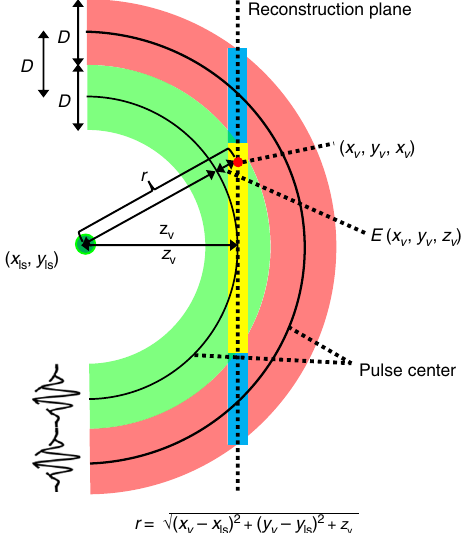
Fig. 4 Spatial sectioning for determining the piece-wise time offset. As the yellow section of the reconstruction plane is closer to the maximum of the green pulse, it will be assigned the travel time of the green pulse. The light blue parts are closer to the maximum of the red pulse and therefore get assigned the travel time of the red pulse.